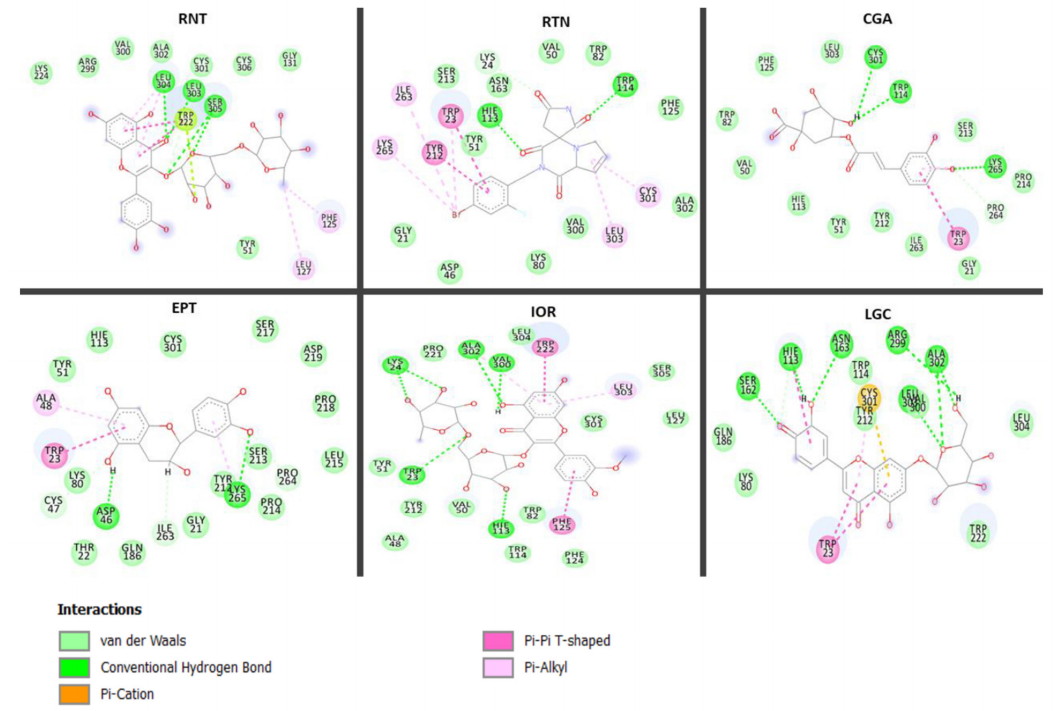
Figure 6. Interaction types and plots between phenolic compounds, standard drug and alpha-glucosidase. ACB: Acarbose; HPS: Hyperoside: PDN; DCA: 1,3-Dicaffeoxyl quinic acid.